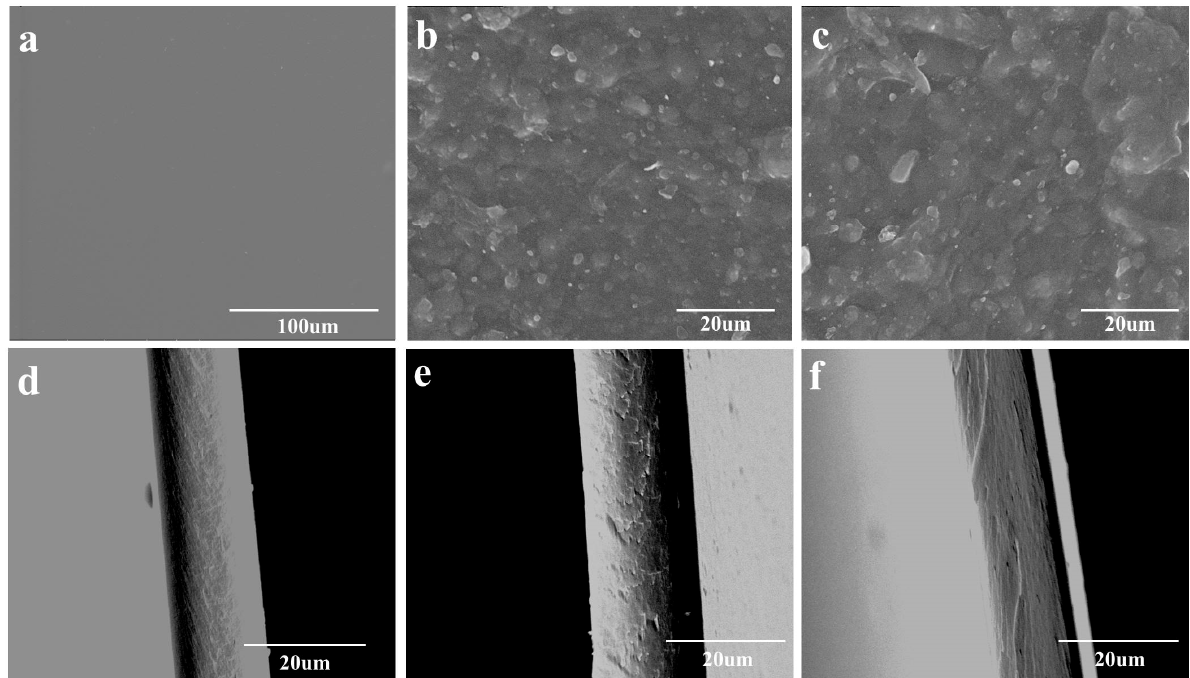
Figure 6. ( a – f ) SEM micrographs of C-film, Film-W and Film-E: ( a – c ) the surface of C-film, Film-W and Film-E; ( d – f ) the cross section of C film, film W, and film E.